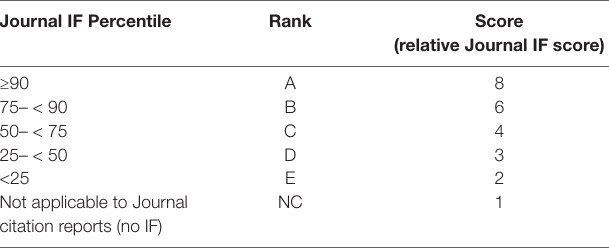
TABLE 1 | Journal rank and score (relative Journal IF score) based on